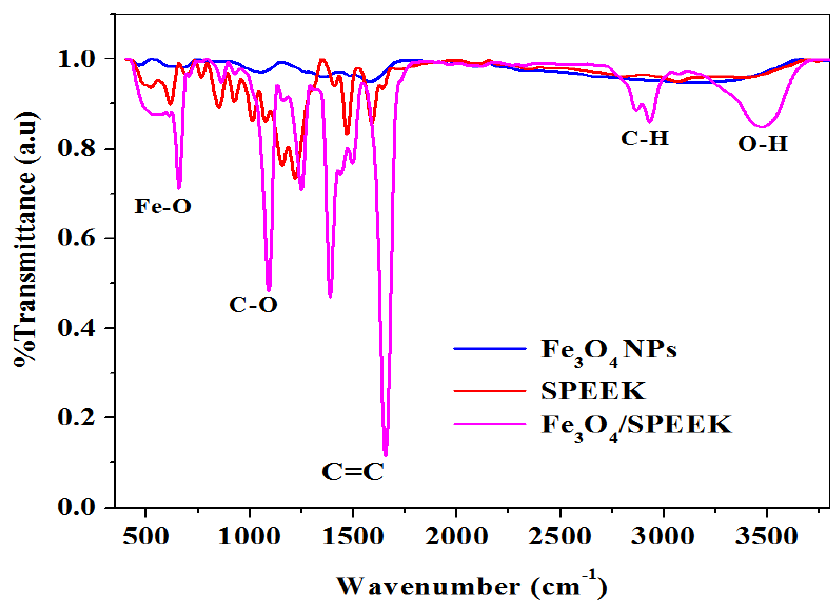
Figure 2. FTIR spectra showing mediated Fe 3 O 4 NPs, polymer SPEEK and Fe 3 O 4 /SPEEK nanocom- posites respectively.